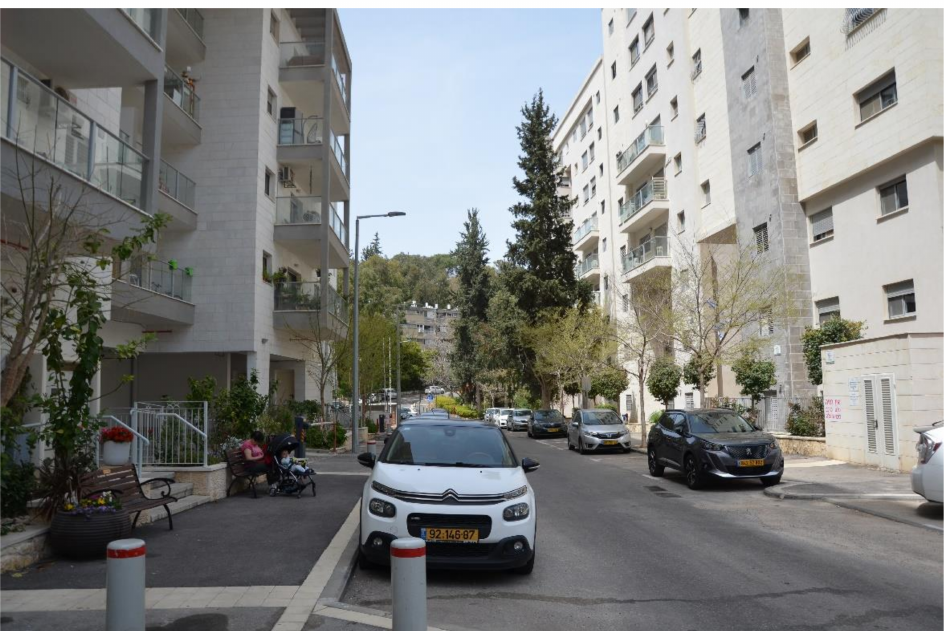
Figure 11. Narrow and dark pavements. Photograph by the authors,